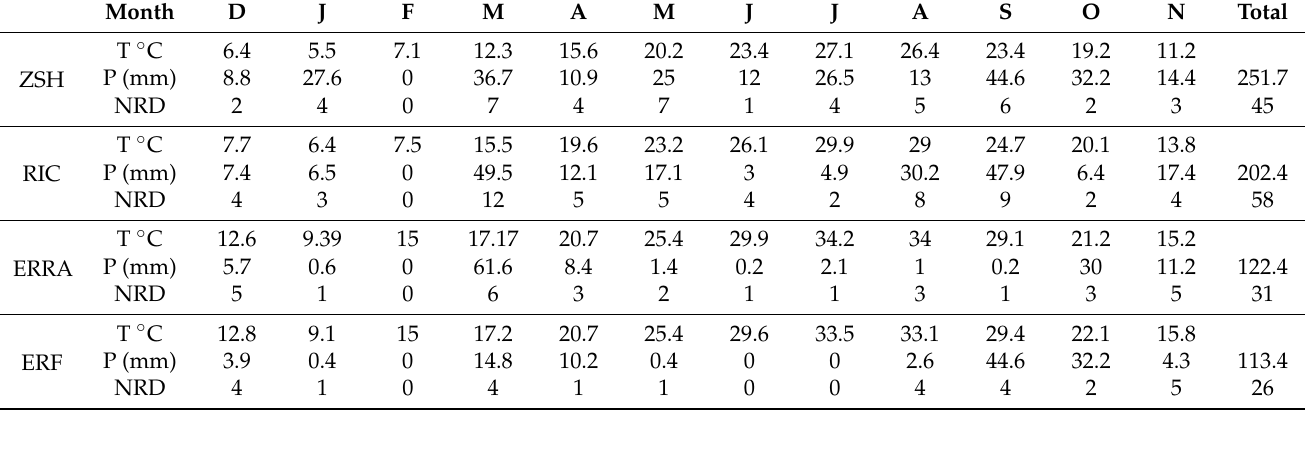
Table 1. Monthly mean temperature (T ◦ C), monthly rain (P) and number of rainy days (NRD) at the